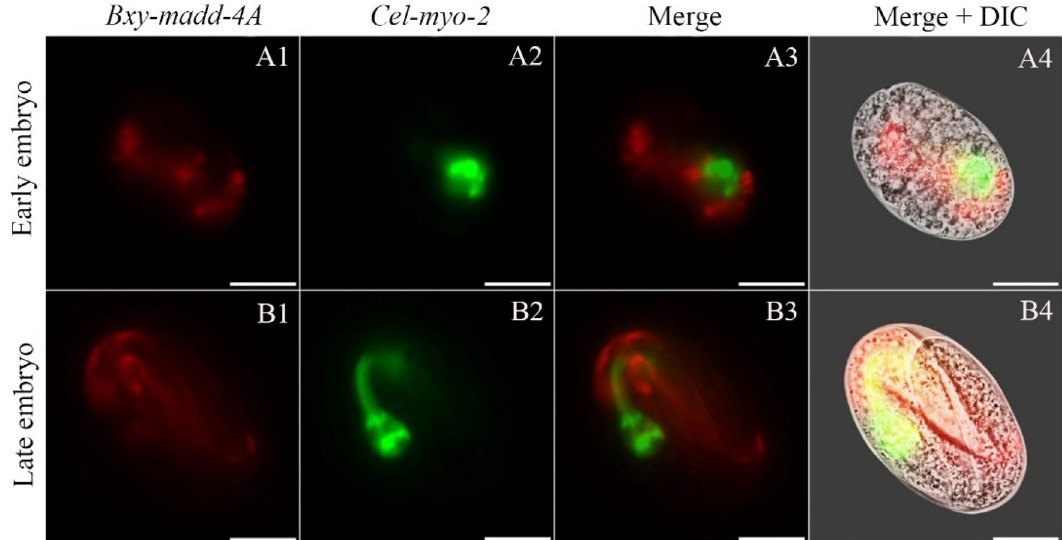
Figure 4. Localization of Bxy-madd-4A on translational level via transgenic C. elegans during embryonic development. The expression patterns of mCherry (red) under control of B. xylophylus madd-4A promoter and green fluorescent protein gene (green) was driven by C. elegans promoter myo-2 as a marker for pharynx development. Fluorescent (A1–A3 and B1–B3) and differential interference contrast (DIC) merged (A4 and B4) microscope images of the second filial generation transgenic C. elegans embryos carrying both Bxy-madd- 4Ap ::mCherry and Pmyo-2 ::GFP transgenes. Early embryo, raised at 20 °C for 6 h; late embryo, raised at 20 °C for12 h. In all cases, images are representative of 50 embryos. The scale bar stands for 10